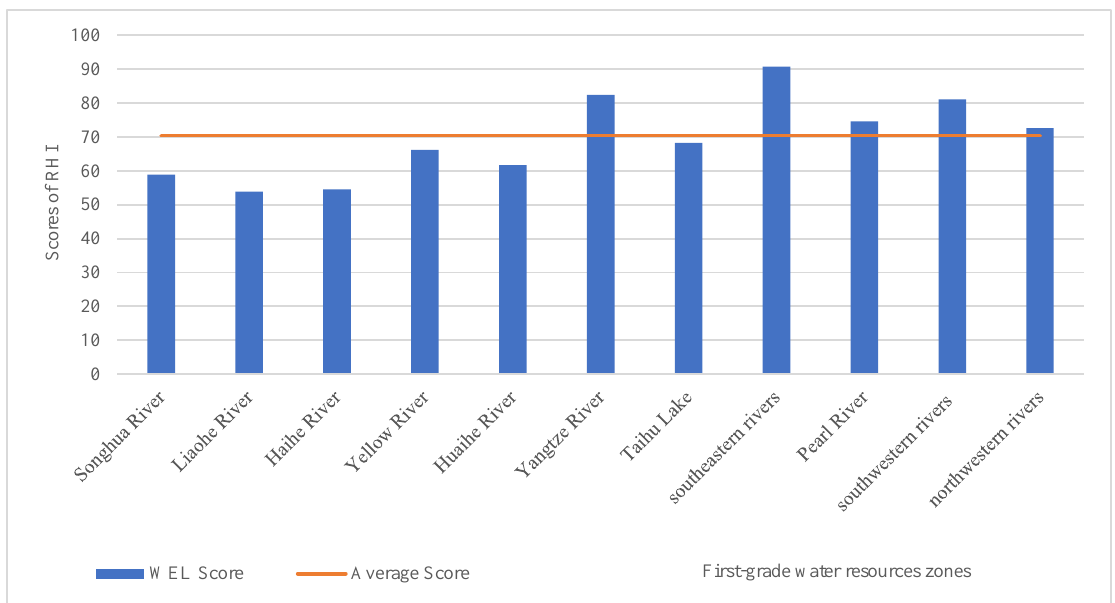
Figure 4. WRR evaluation results for China’s first-grade water resource zone.